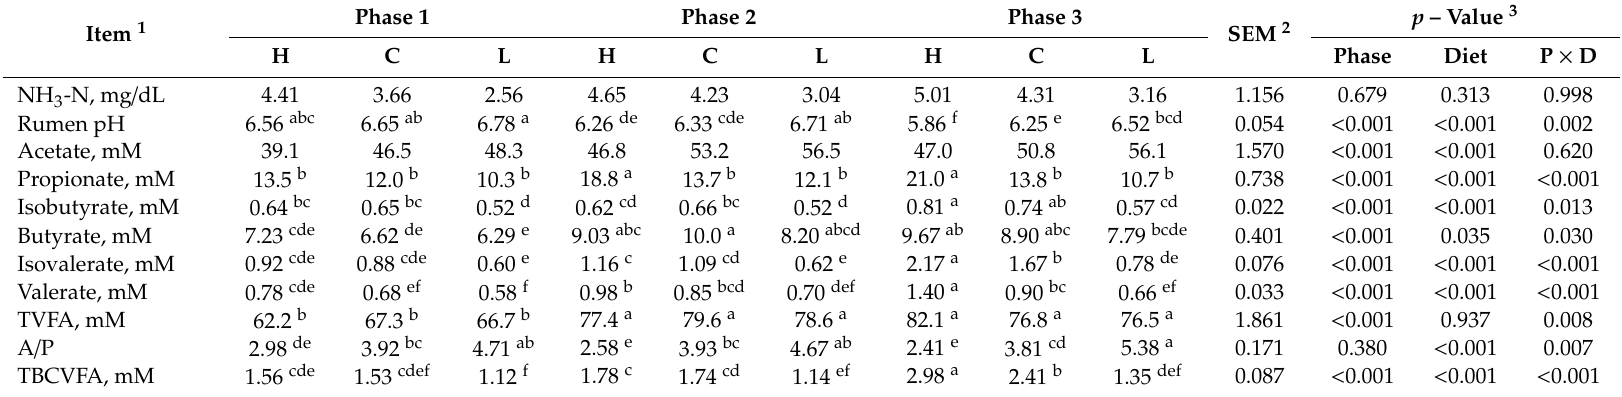
Table 4. E ff ects of dietary nutrient density on rumen fermentation characteristics in the whole fattening phases of Holstein